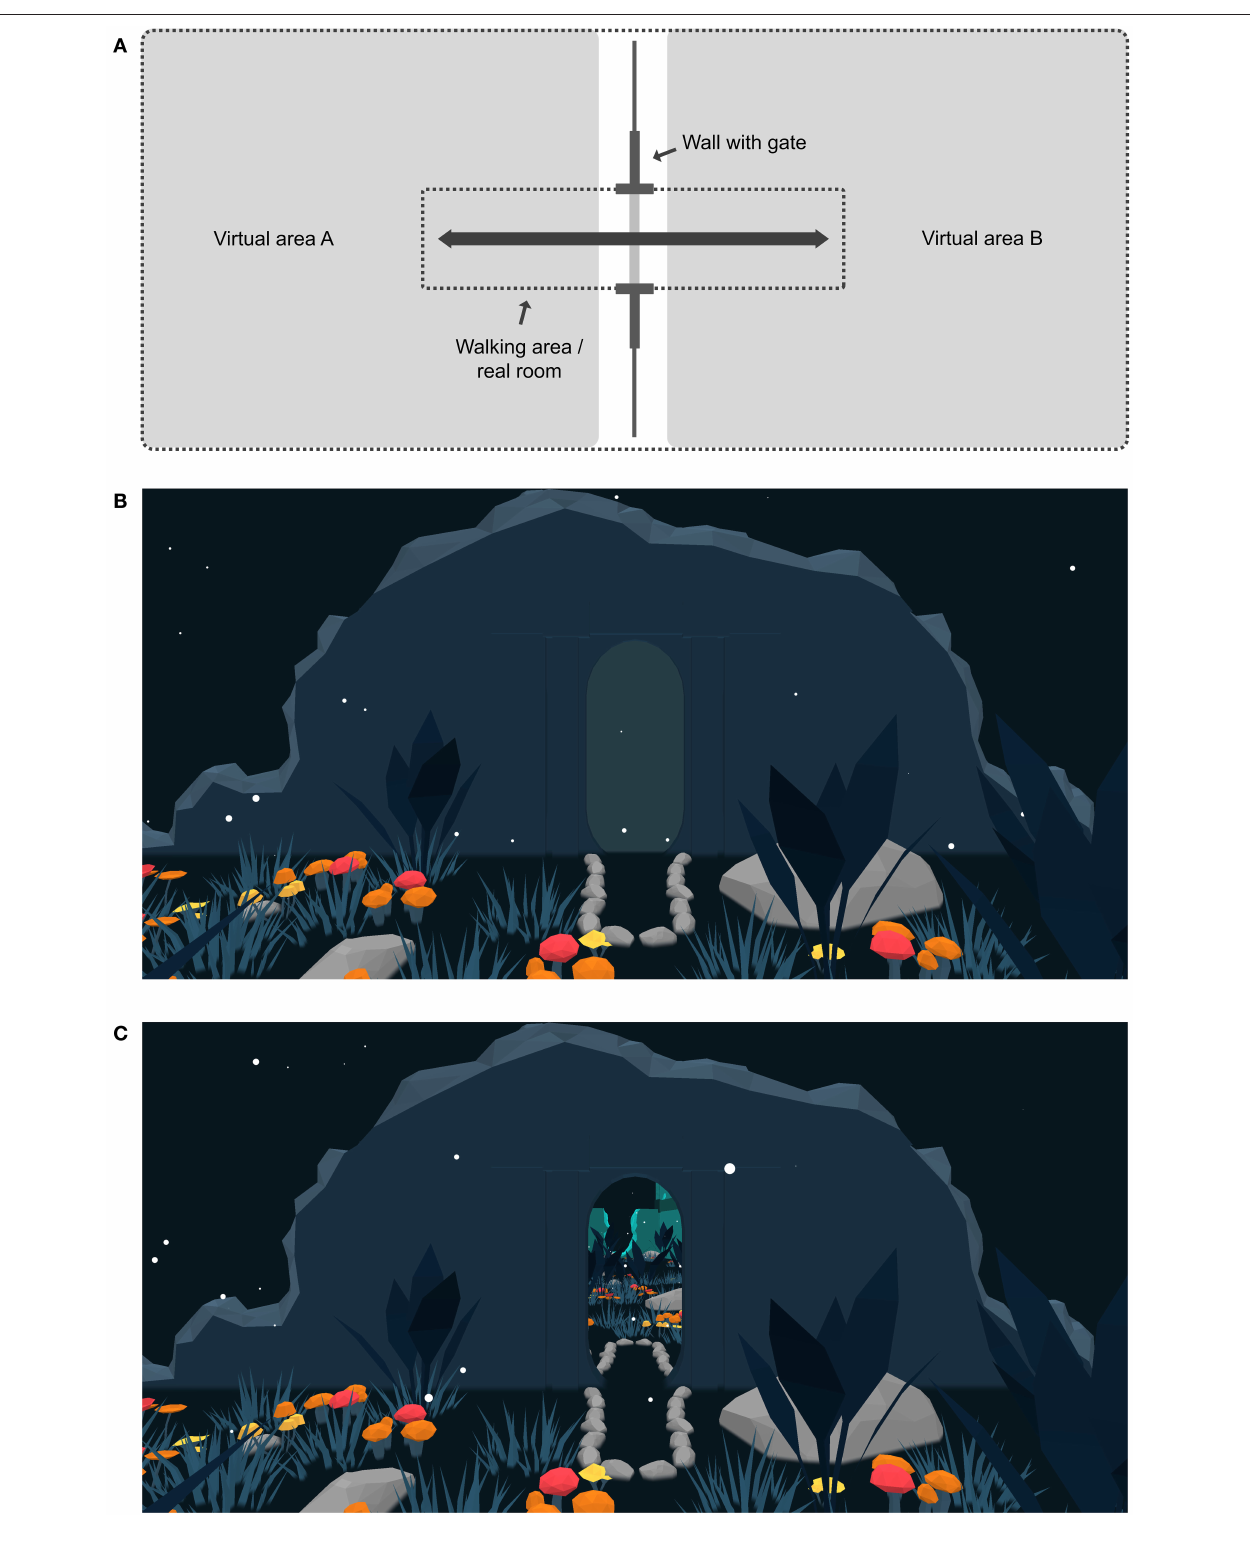
FIGURE 2 | (A) Layout of the virtual environment (view from top). The user walks back and forth within the walking area (dark double arrow). When the user steps into virtual area A, the gate closes and the environment in virtual area B is exchanged, and vice versa. (B) Screenshot of the separating wall with closed gate. The small rocks on the floor outline the area within which the participants are supposed to walk. (C) Screenshot of the separating wall with open gate.